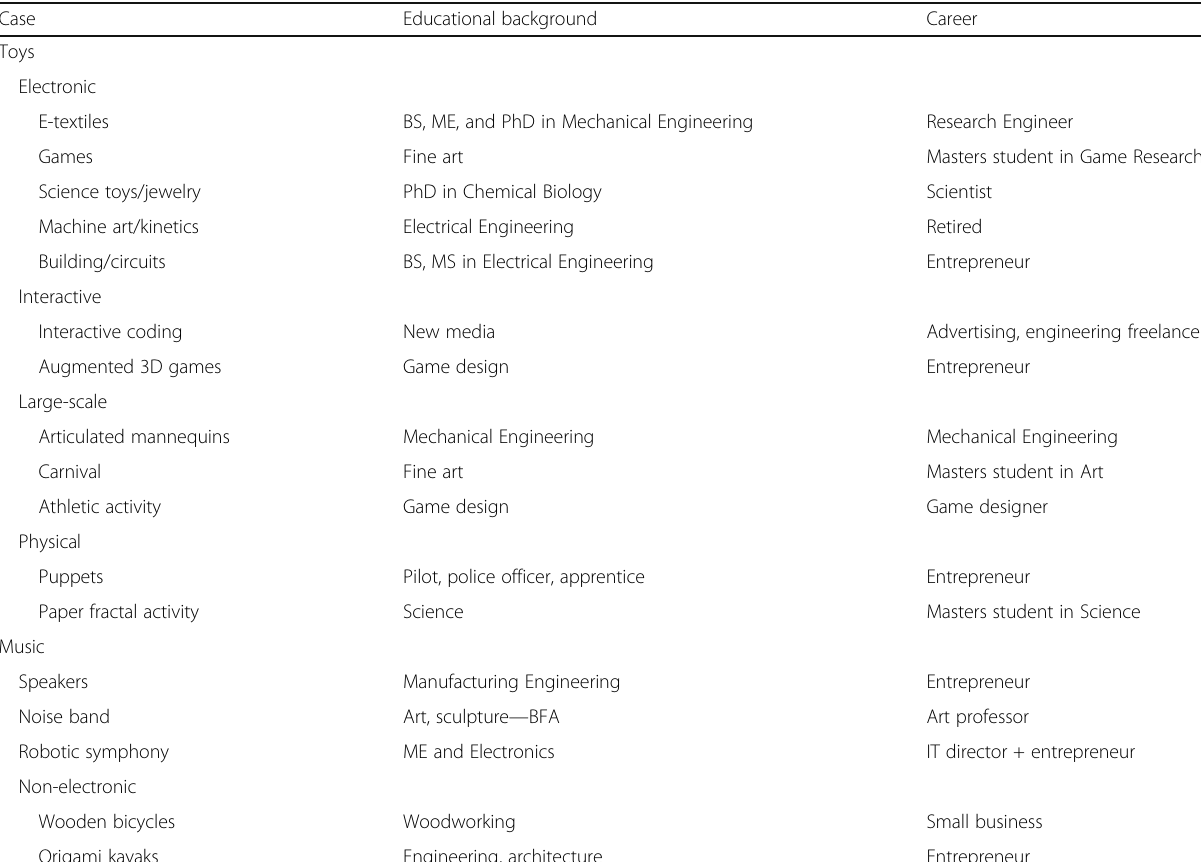
Table 8 A list of cases and the Makers that comprise them